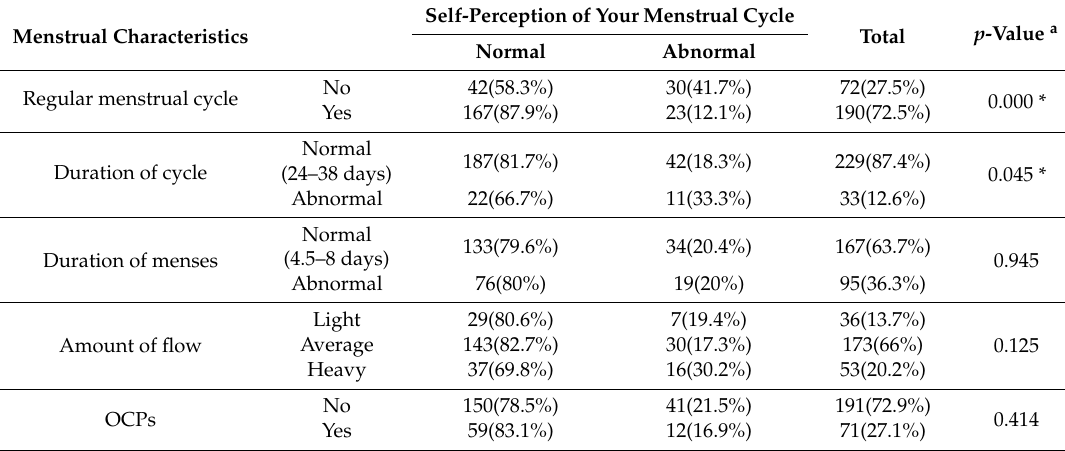
Table 1. Comparison of menstrual characteristics in women with self-perception of normality and menstrual